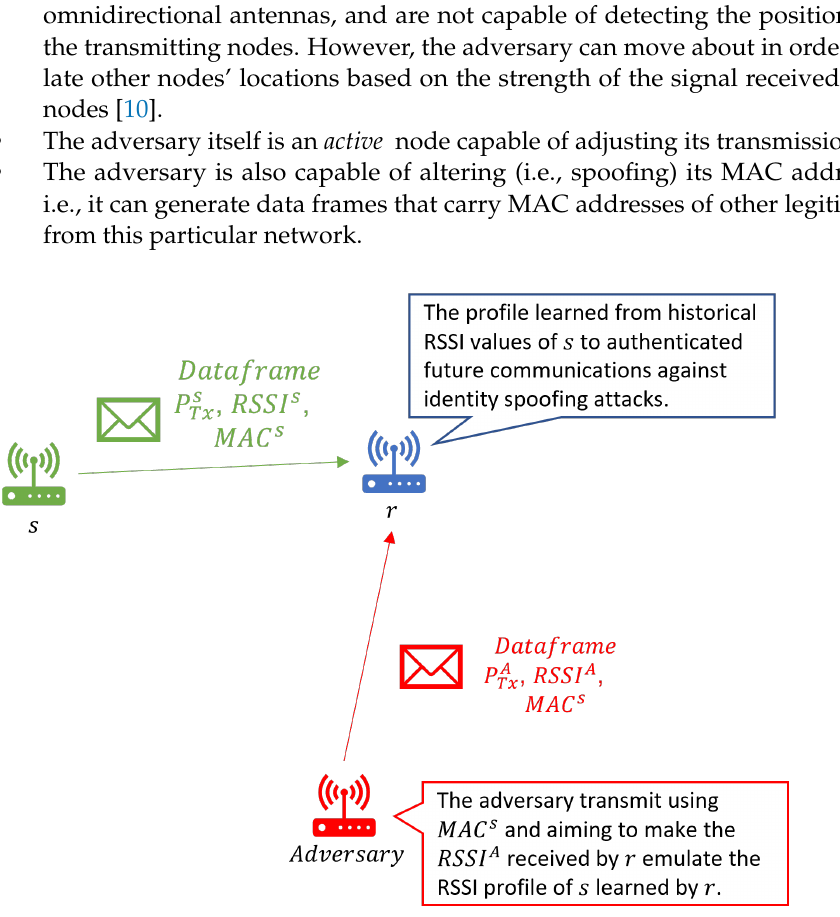
Figure 2. Overview of the threat model: the goal of the receiving node is to use historical (clean) RSSI values from the legitimate sender to learn a robust profile to use in future against identity attacks; while the goal of the adversary is to get past the established profile by taking over s